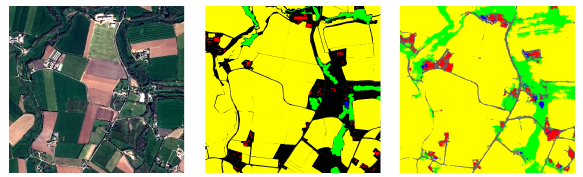
Figure 1. Coverage of the training data. From left to right: Spot 6 image, training data, classification. (cid:108) no training data, (cid:108) buildings, (cid:108) roads, (cid:108) crops, (cid:108) forest, (cid:108) water